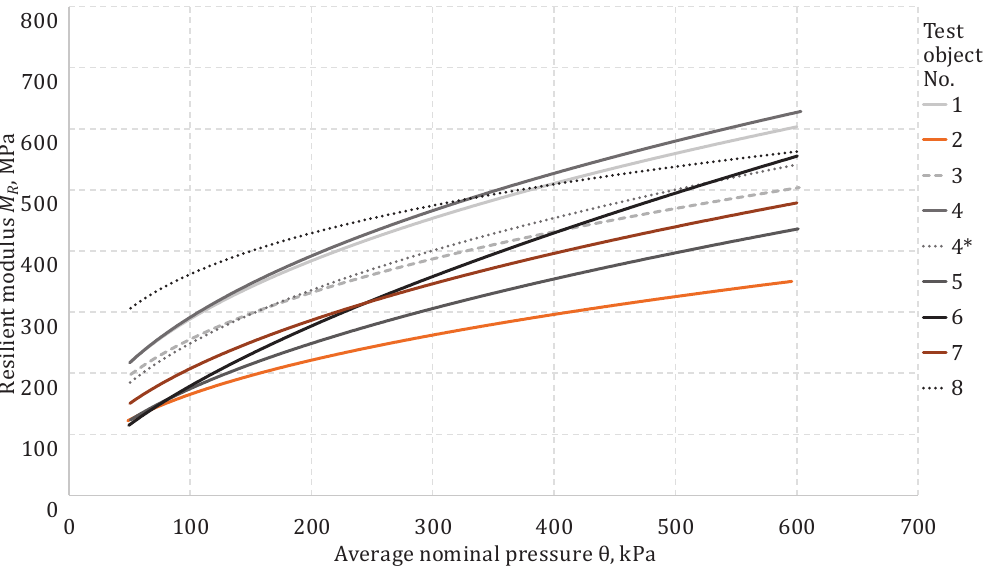
Figure 2. Resilient modulus dependency on aggregate mixtures within different nominal